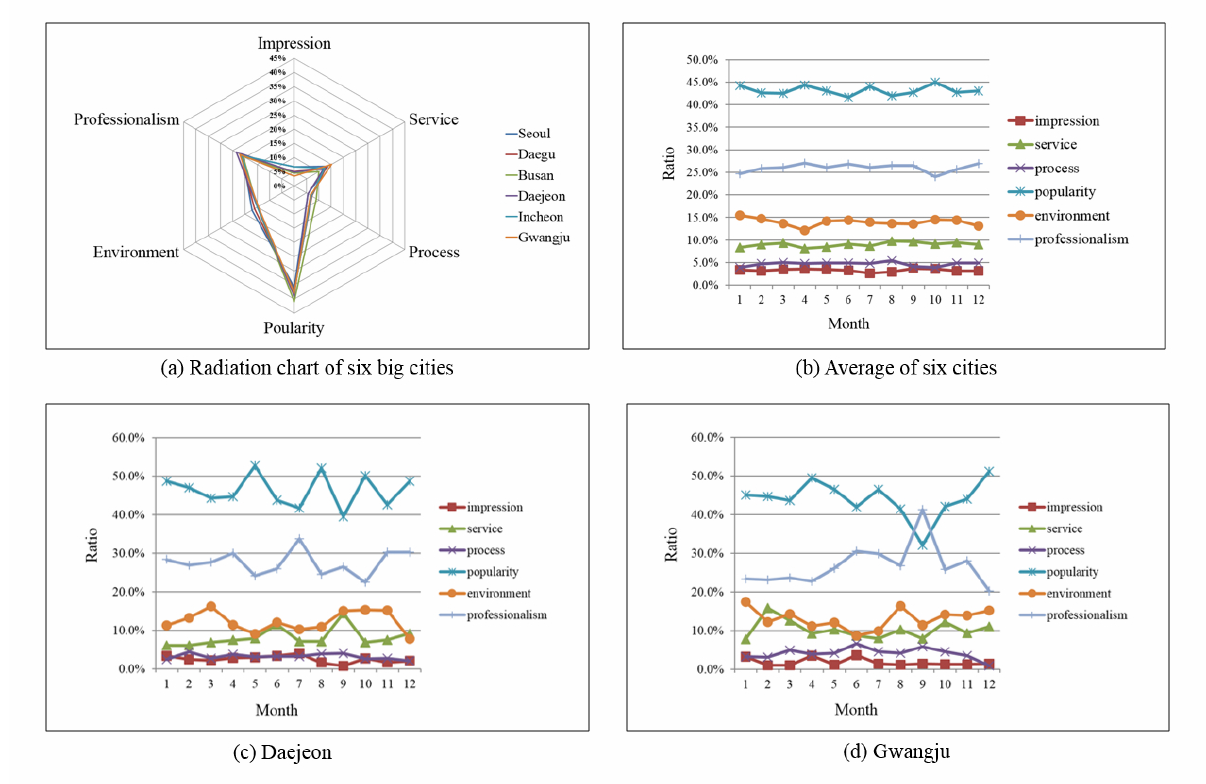
Figure 5. An example of overall quality factor